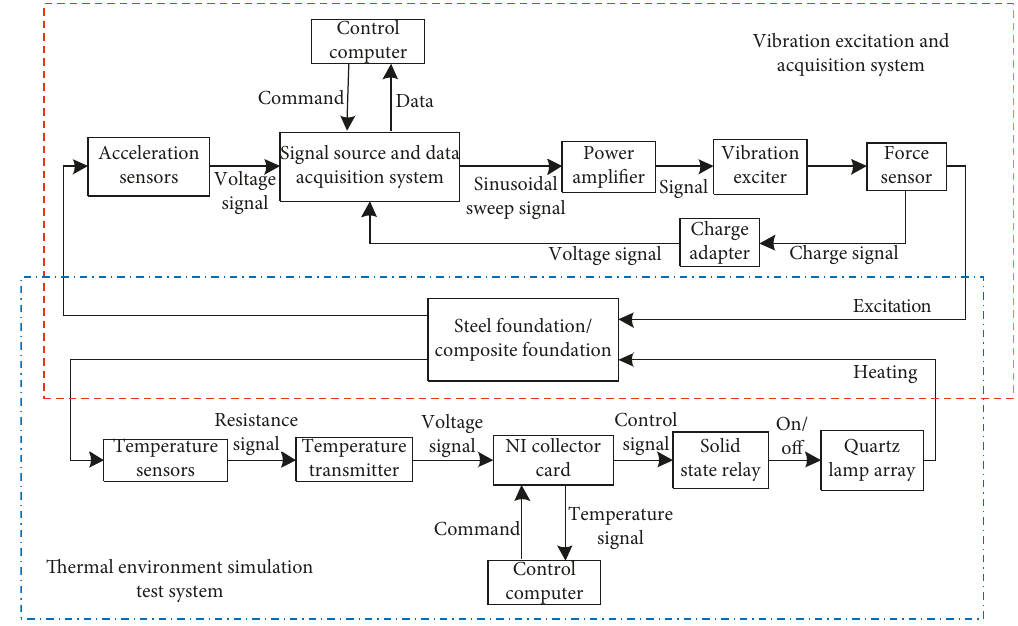
Figure 16: Block diagram of the thermal-vibration joint test system.